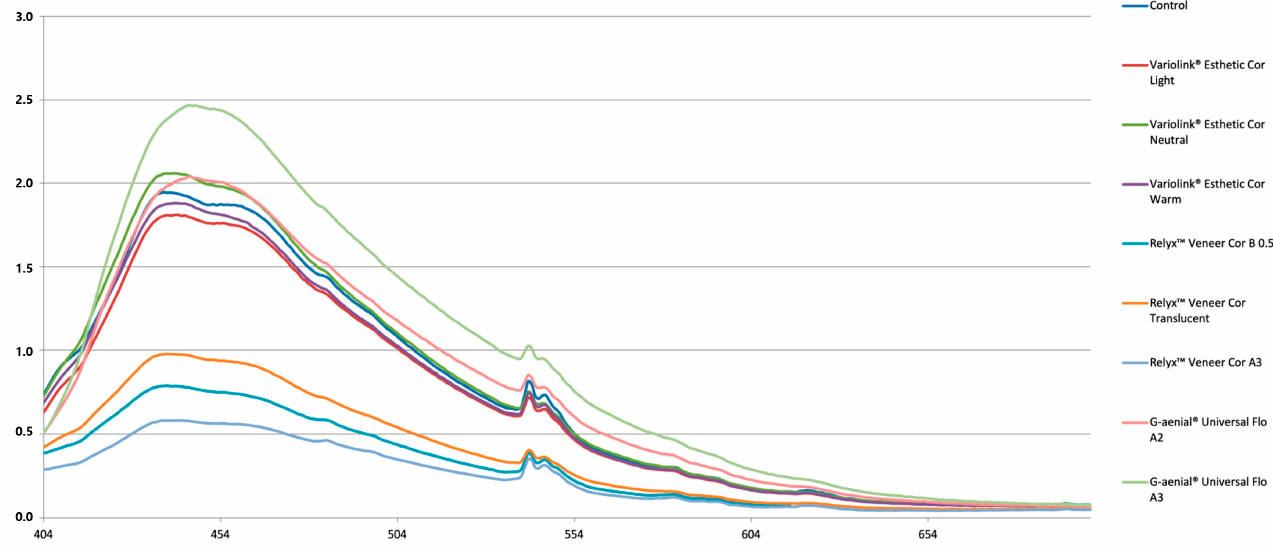
Figure 1. Fluorescence emission spectra different groups according to resin-based material used for luting feldspathic veneers (0.5 mm thickness). Graph values are in millions of a.u.